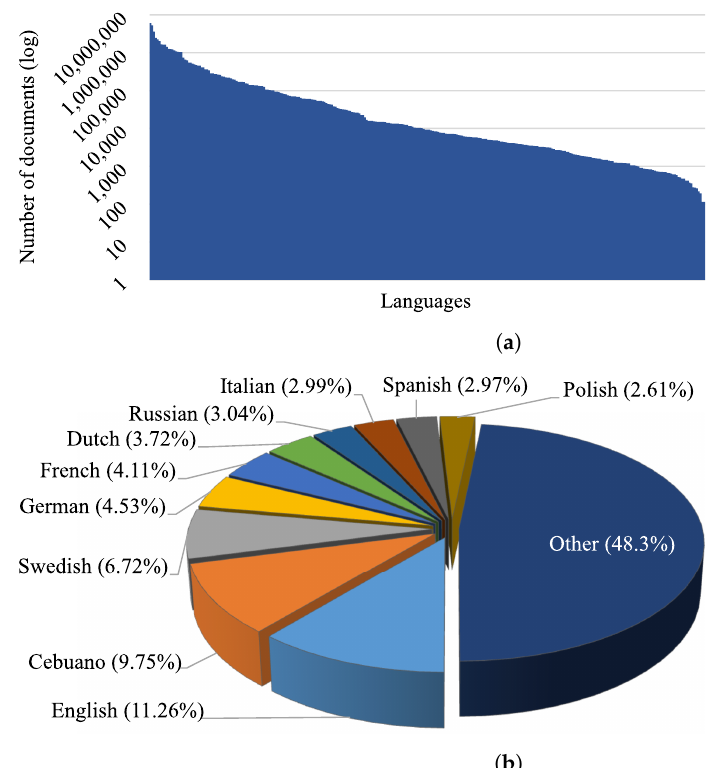
Figure 1. Multilingual statistics of Wikipedia. ( a ) Number of documents per language. The y -axis is in log scale and the x -axis includes 303 languages, sorted by the number of documents. ( b ) Top 10 languages with most documents and their respective